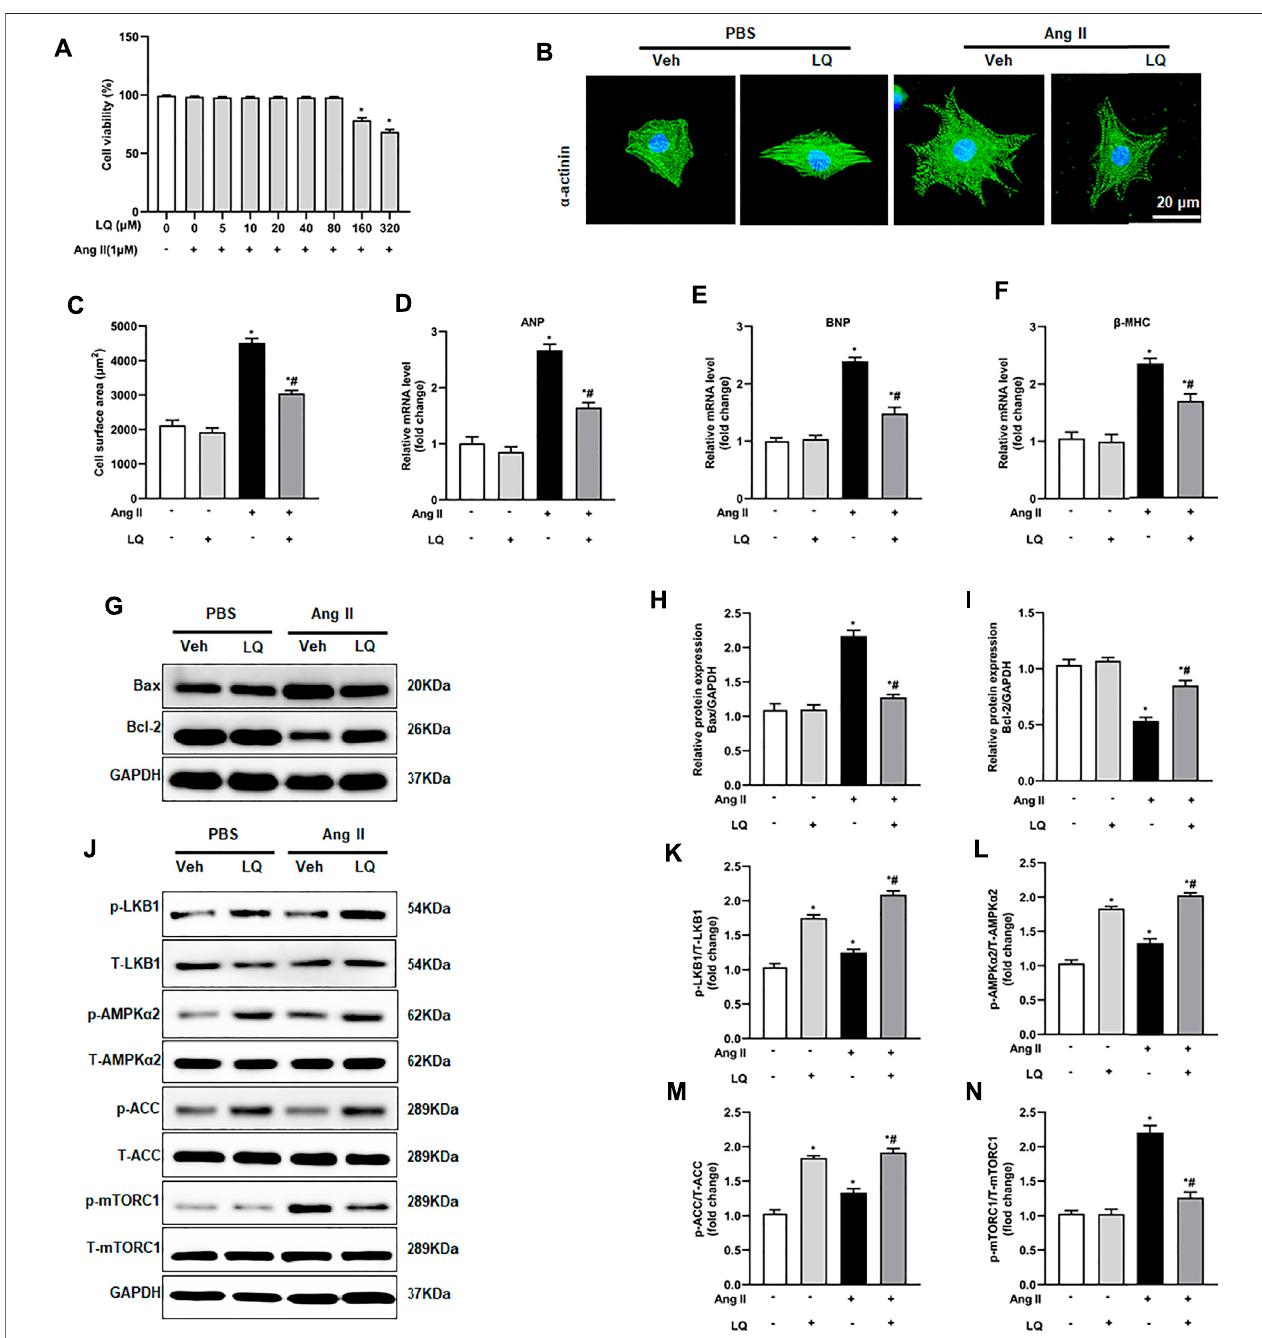
FIGURE 7 | Liquiritin attenuates Ang II-induced cardiomyocyte hypertrophy in vitro. (A) Analysis of cell viability (CCK-8 assay) in neonatal rat ventricular cardiomyocytes (NRCMs) exposed to different concentrations of LQ (0, 5, 10, 20, 40, 80, 160, and 320 µM) and 1 mM Ang II ( n = 6). (B) Representative images of a-actinin immuno fl uorescence (green) in NRCMs. Nuclei were stained with DAPI (blue). (C) Cell surface area (CSA) estimations based on quanti fi cation of a-actinin immuno fl uorescence ( n = 6 replicates per group). Relative mRNA expression levels of (D) ANP, (E) BNP, and (F) β -MHC in NRCMs ( n = 6 per group). (G) Representative immunoblots for Bax and Bcl-2. Relative expression levels of (H) Bax and (I) Bcl-2 based on western blot results ( n = 6). Signals were normalized to GAPDH. (J) Representative immunoblots for p-LKB1, T-LKB1, p-AMPK α 2, T-AMPK α 2, p-ACC, T-ACC, p-mTORC1, and T-mTORC1, and (K – N) corresponding quanti fi cationdata( n =6).All invitro experimentswererepeatedthreetimesindependently.Dataarepresentedasthemean±SEM.One-wayANOVAwasperformedto examine statistical differences among different groups. * p < 0.05 vs. the corresponding PBS + Veh group; # p < 0.05 vs. Ang II + Veh.